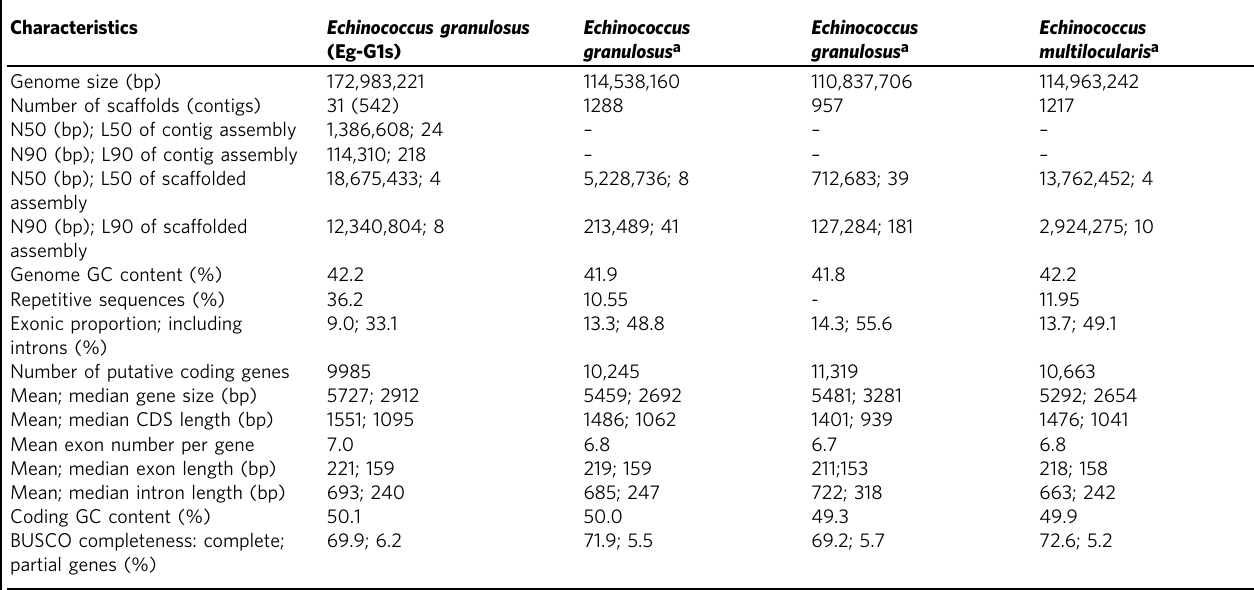
Table 1 Genome features.